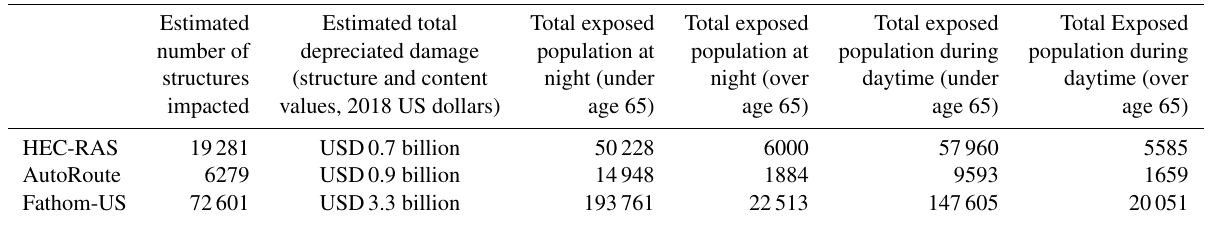
Table 4. Consequence and exposure estimates for Clear Creek during Hurricane Harvey estimated using each FIM and the go-consequences software.